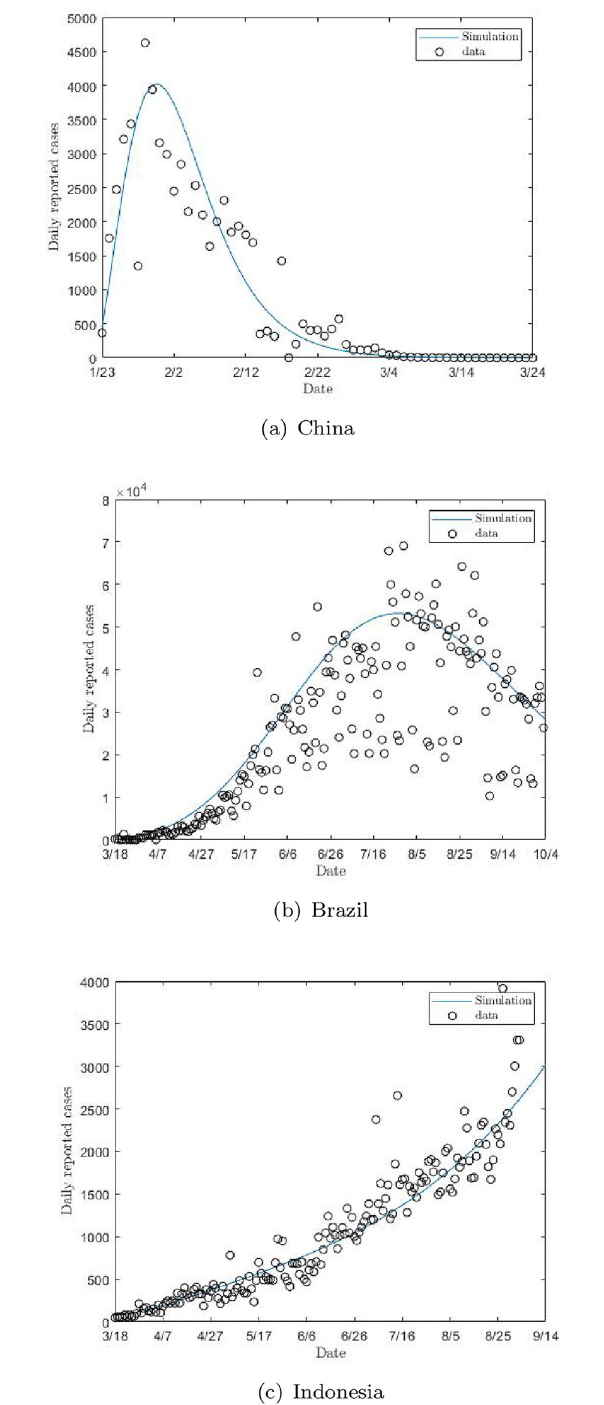
Fig 2. Observed daily new cases (dots) and model fitting results (solid curve) for China (a), Brazil (b) and Indonesia (c).